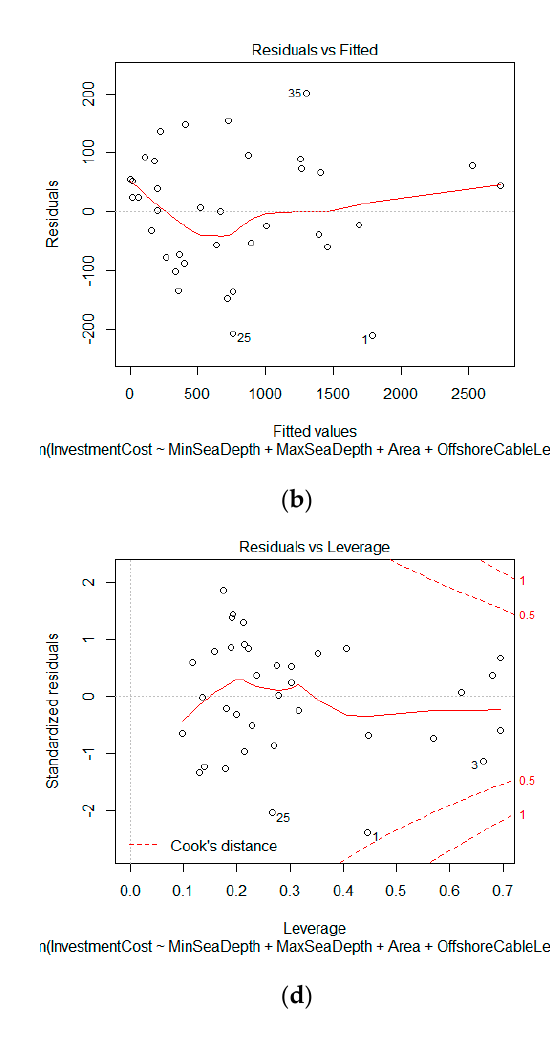
Table 1. Variance inflation factor of the different models of independent variables.